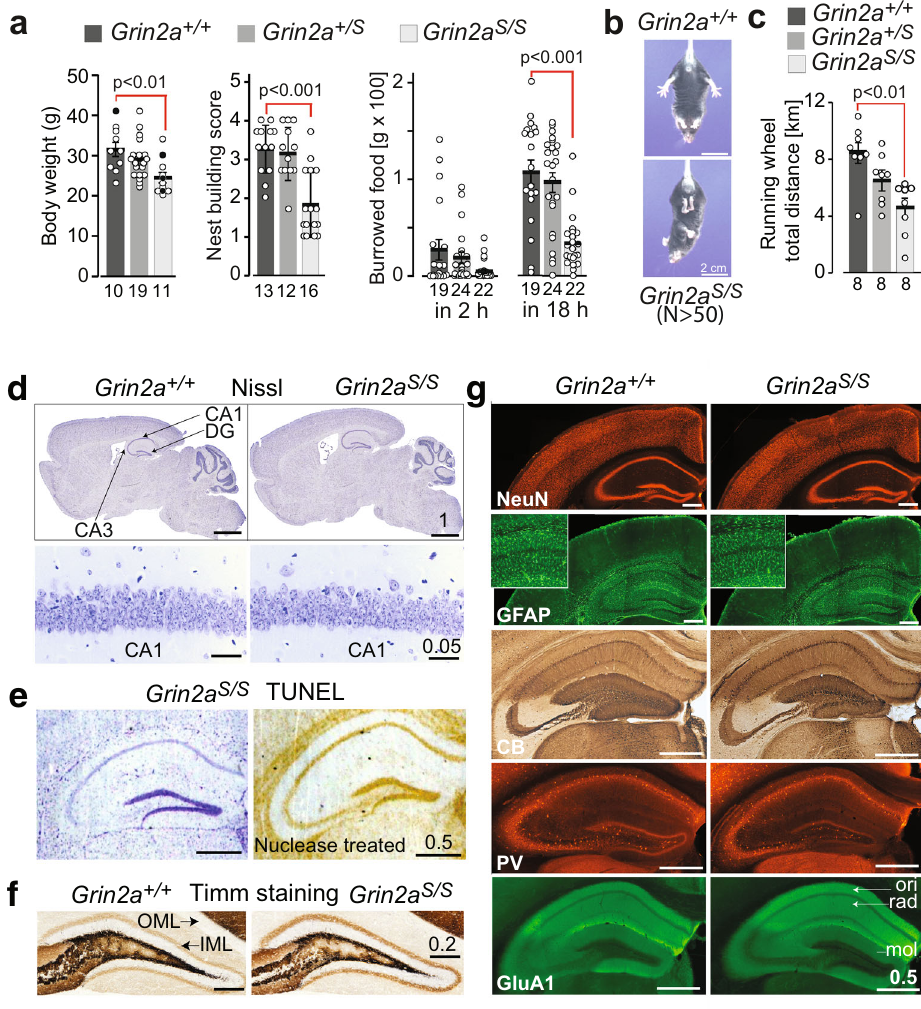
Fig. 3 Grin2a S/S mice are viable and show no signs of neurodegeneration or altered brain structure. a Grin2a S/S mice had a reduced body weight (by 18% in adults), signi fi cantly lower score in nesting and in overnight burrowing activity ( fi lled circles: 30-week-old mice, white dots: 18-week-old mice). b Grin2a S/S mice showed the clasping re fl ex. c During the 12 h dark phase on the Lafayette running wheel the running distance is reduced in Grin2a S/S mice. d Nissl staining revealed unaltered cell density throughout the brain (top) and layering of hippocampal sub fi elds, including CA1 (bottom), in Grin2a S/S mice compared to Grin2a + / + . Error bars represent mean ± SEM. e In the TUNEL assay no apoptotic cells could be detected in the hippocampus of Grin2a S/S mice, compared to the staining of the nuclease-treated positive control slice. f No aberrant mossy fi ber sprouting in either genotype in the dentate gyrus inner (IML) and outer molecular layer (OML) can be found by Timm staining of coronal sections. g The distribution of NeuN-positive neurons and of GFAP- positive glial cells are indistinguishable between Grin2a S/S and Grin2a + / + mice. Mossy fi ber projections visualized by anti-calbindin (CB) staining, as well as numbers of parvalbumin (PV)-positive interneurons are similar between both genotypes. Anti-GluA1 immunosignal in all hippocampal layers is comparable between brain sections of Grin2a S/S mice and control littermates. CA1 cornu ammonis region 1, CA3 cornu ammonis region 3, DG dentate gyrus, mol stratum moleculare, ori stratum oriens, rad, stratum radiatum. Scale bars in d – g are in mm. The number of animals is given below the bars. For the Nissl stain, Tunnel test and Timm stain 3 mice were used per genotype. For the immunohistological analysis of glial fi brillary acidic protein (GFAP), neuronal nuclear antigen (NeuN), Calbindin (CB), and Parvalbumin (PV) fi ve mice and for the GluA1 immuno fl uorescence stain, three mice were used (for statistics: Supplementary Statistics to Fig.